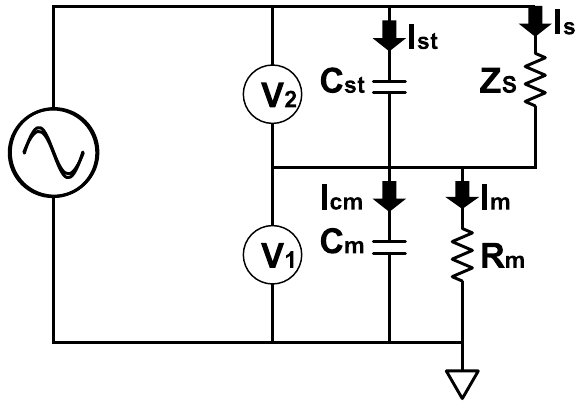
Figure 1. Simplified schematic diagram of a potentiostat in a two-electrode cell setup used for measuring the transimpedance and stray capacitance of the potentiostat used in this work. Z s denotes the impedance of the system being measured, I s is the current flowing through Z s , C st is the stray capacitance and I st is the current flowing through C st . R m is the current measuring resistor, V 2 denotes the voltage drop across Z s and C st , while R m and C m . I cm and I m represent the current flowing through C m and the V 1 denotes the voltage drop across measured current